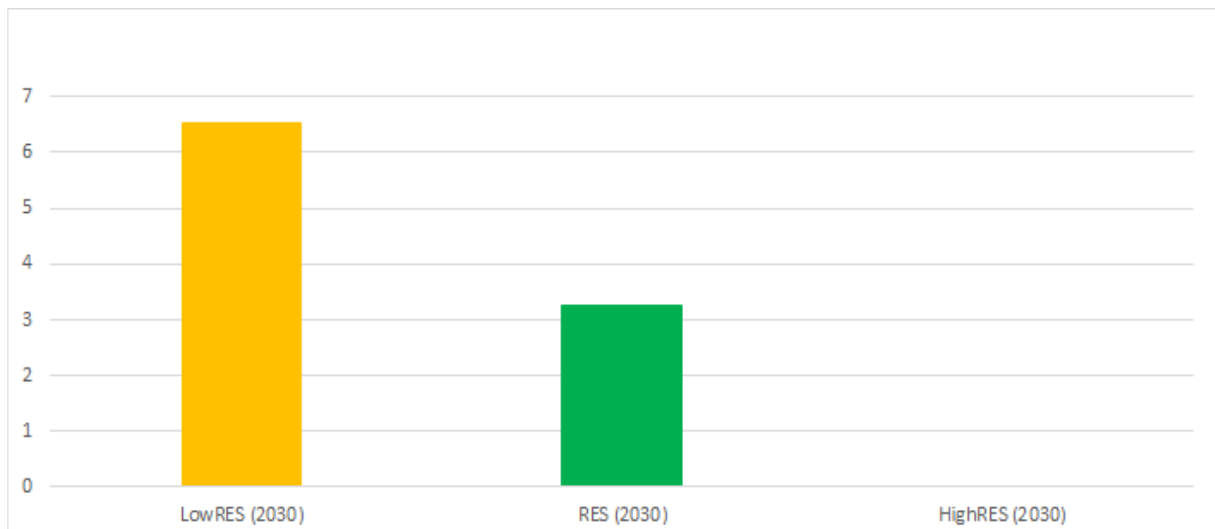
Figure 10. Overall downstream job position creation per scenario for Procida Municipality.